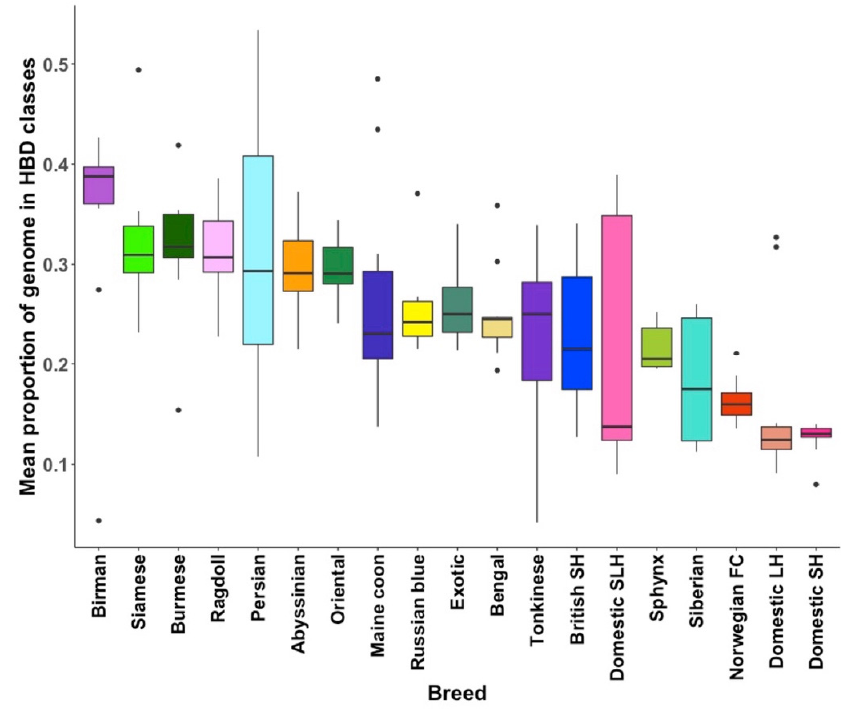
Figure 6. A boxplot diagram representing the mean proportion of each breed’s genome partitioned into HBD segments. On average, random-bred (i.e., DSH, DLH, DSLH) cats have the lowest propor- tion of their genome in HBD segments, whilst the Birmans had the highest proportion of their ge- nome in HBD segments.